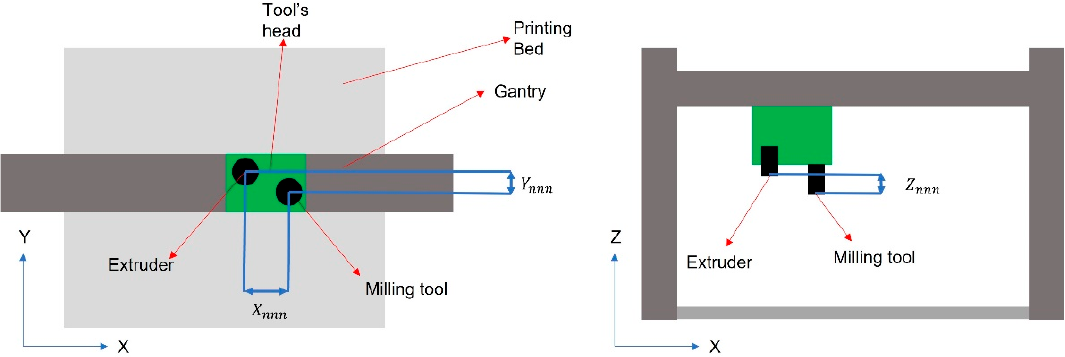
Figure 3. Schematic representation showing the relative position of both tools in the machine.